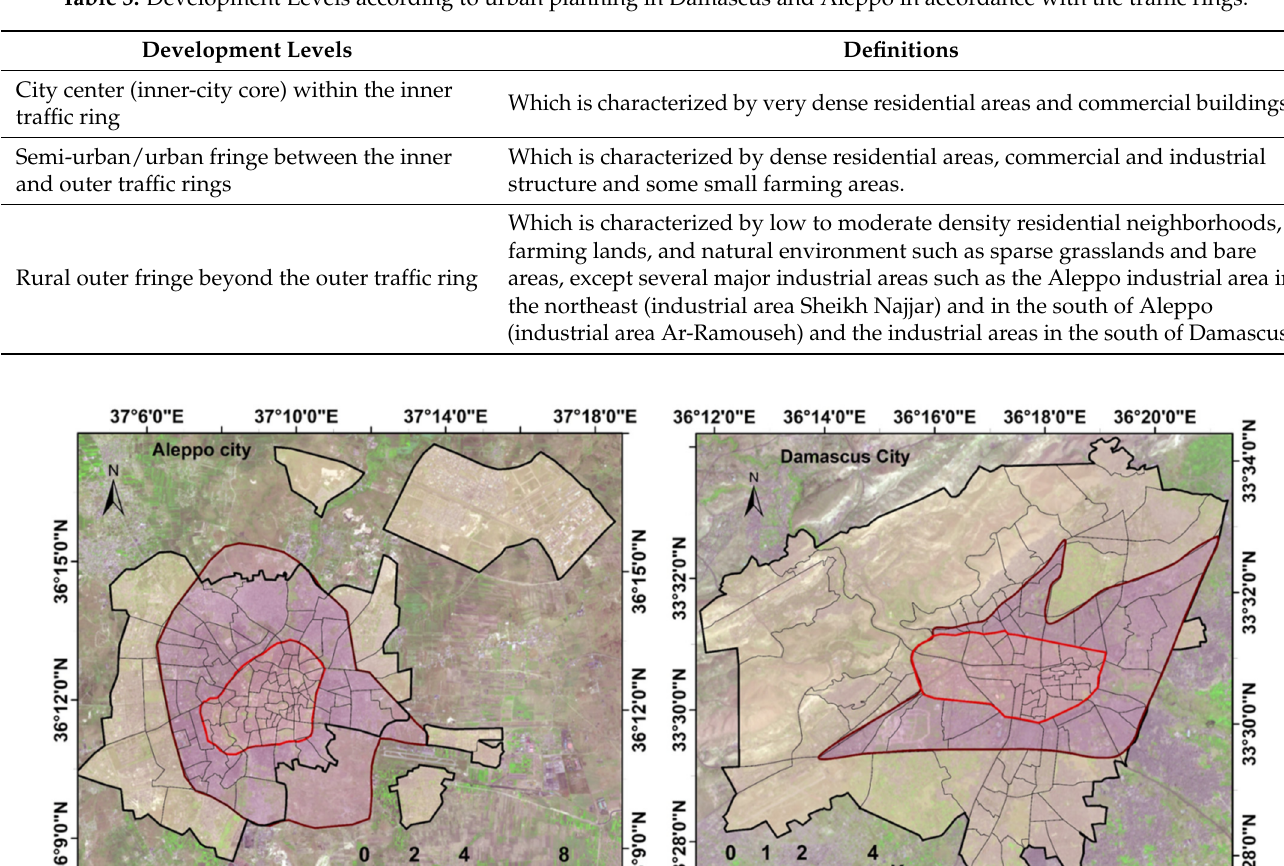
Table 3. Development Levels according to urban planning in Damascus and Aleppo in accordance with the traffic rings.